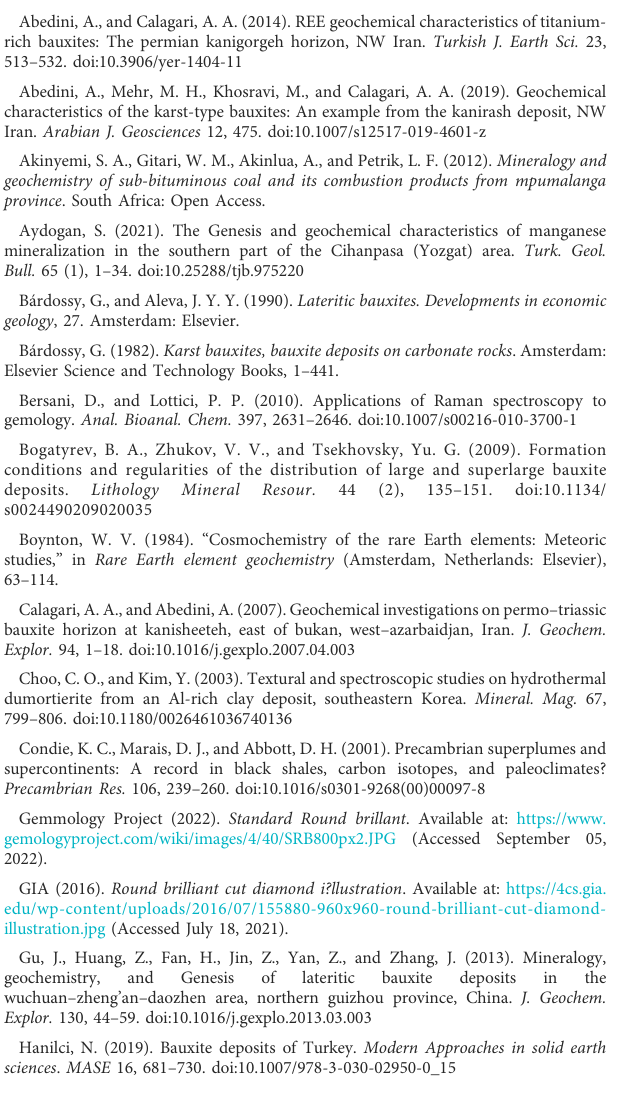
SUPPLEMENTARY FIGURE S5 Logarithmic (y-axis) distribution graphs of some elemental major and trace elements of diaspore formations. SUPPLEMENTARY FIGURE S6 10 μ magni fi cation SEM-EDS dot and mapping images of the S-1 diaspore sample in the Sodra region. SUPPLEMENTARY FIGURE S7 SEM-EDS dot and mapping images with 10 μ magni fi cation of the S-2 diaspore sample in the Sodra region. SUPPLEMENTARY FIGURE S8 SEM-EDS dot and mapping images with 10 μ magni fi cation of the diaspore sample S-3 in the Sodra region. SUPPLEMENTARY FIGURE S9 10 μ magni fi cation SEM-EDS dot and mapping images of the S-4 diaspore sample in the Sodra region. SUPPLEMENTARY FIGURE S10 Mineral contents determined by Raman spectroscopy (S-1, S-2, S-3 and S-4) in diasporesamplesfromtheSodraregion.FTIRplotsofdiasporesamplestakenin theSodraregion(blue lines are FTIR standards, redlinesarediasporesamples).